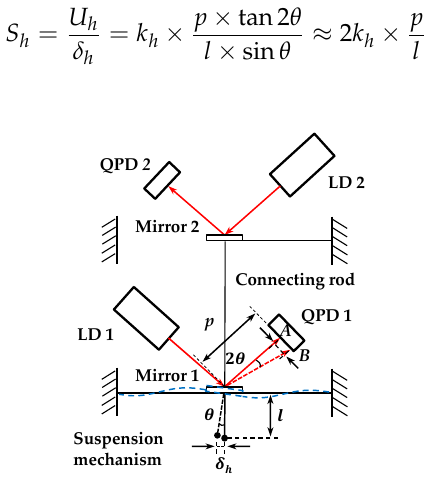
Figure 7. Sensing principle in horizontal direction.